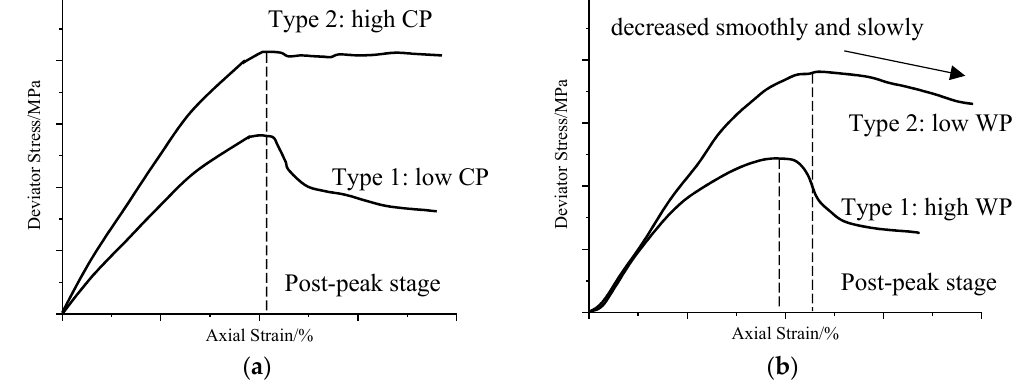
Figure 5. Sketch diagram of stress–strain curve types in triaxial tests. ( a ) Triaxial compression test; ( b ) hydraulic coupled triaxial test.